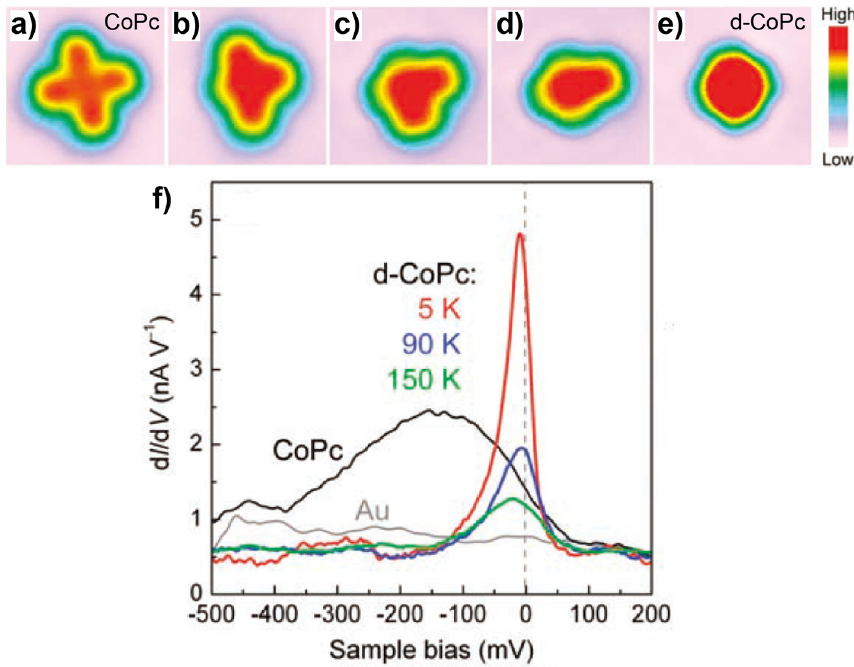
Figure 4. ( a – e ) STM images showing the sequential tip-induced dehydrogenation of a CoPc on ( f ) d I / d V spectra of CoPc and dehydrogenated CoPc (d-CoPc) at di ff erent temperatures. Au(111). ( f ) d I /d V spectra of CoPc and dehydrogenated CoPc (d-CoPc) at different temperatures. Adapted from [68], with permission from American Association for the Advancement of Science, 2005.